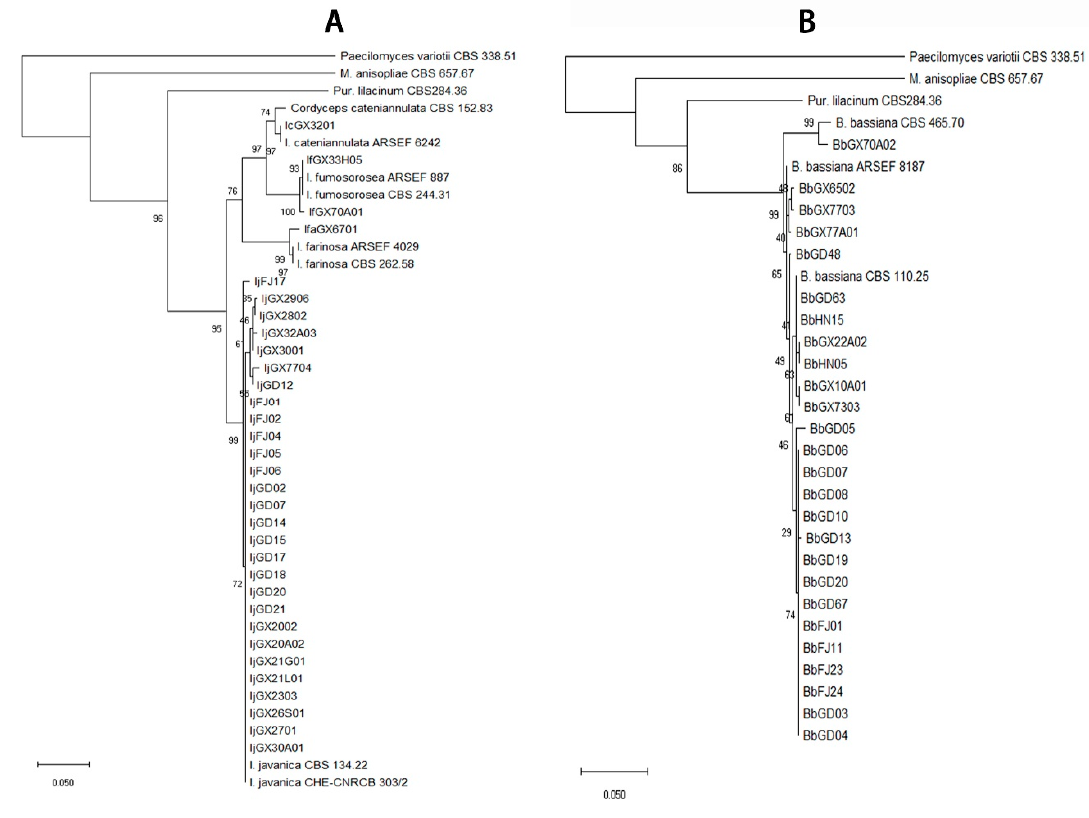
Figure 3. Phylogenetic tree of the Isaria spp. ( A ) and Beauveria bassiana ( B ) isolates.